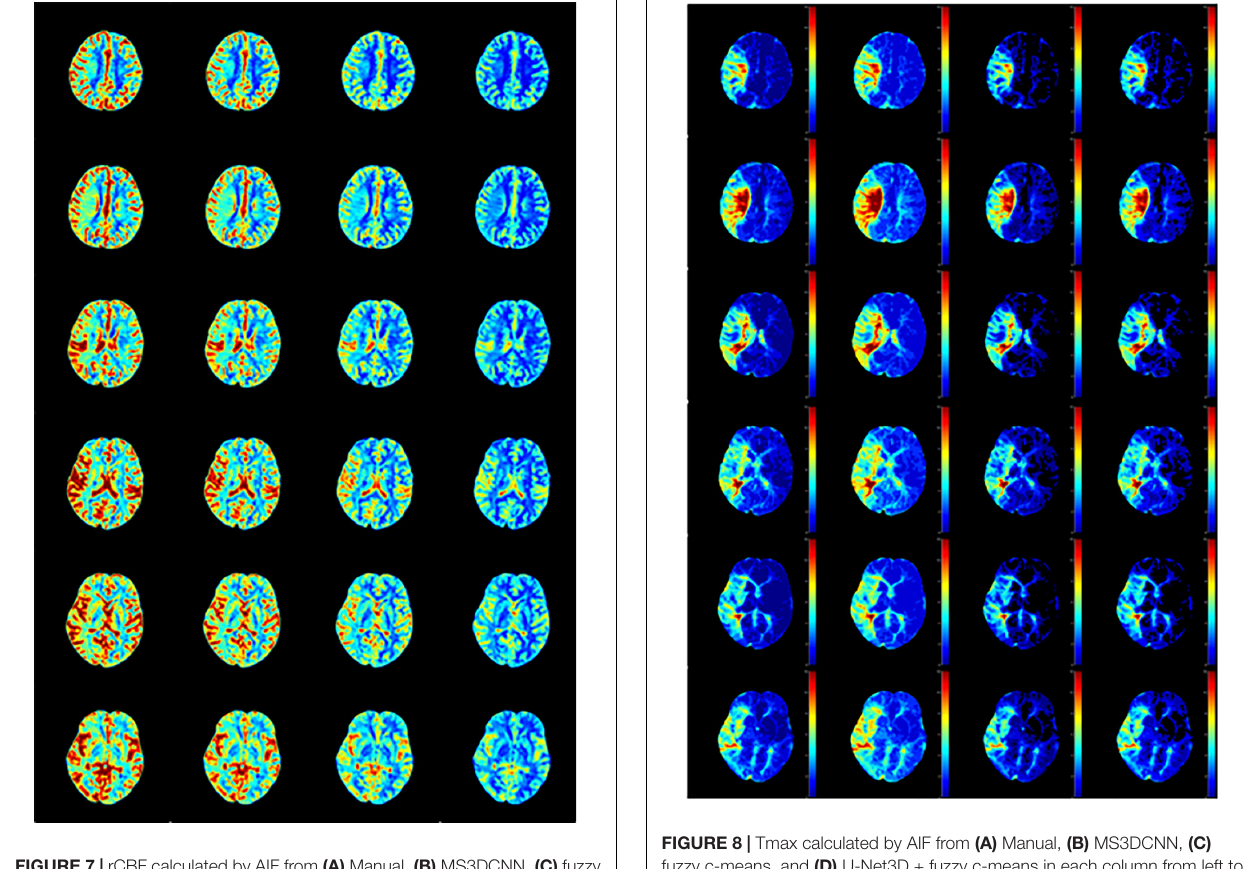
TABLE 4 | The difference of Tmax and rCBF between the automated methods and the manual method.